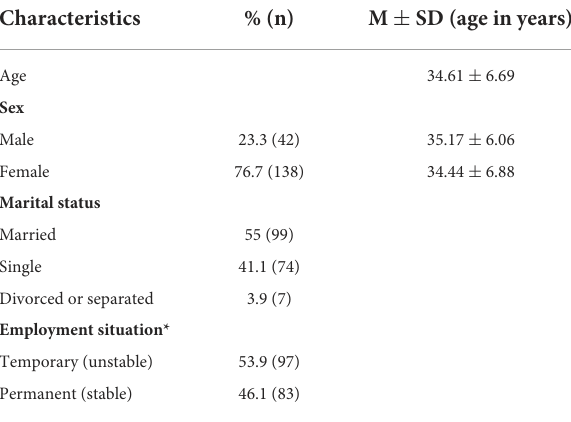
TABLE 1 Sociodemographic characteristics of the sample.